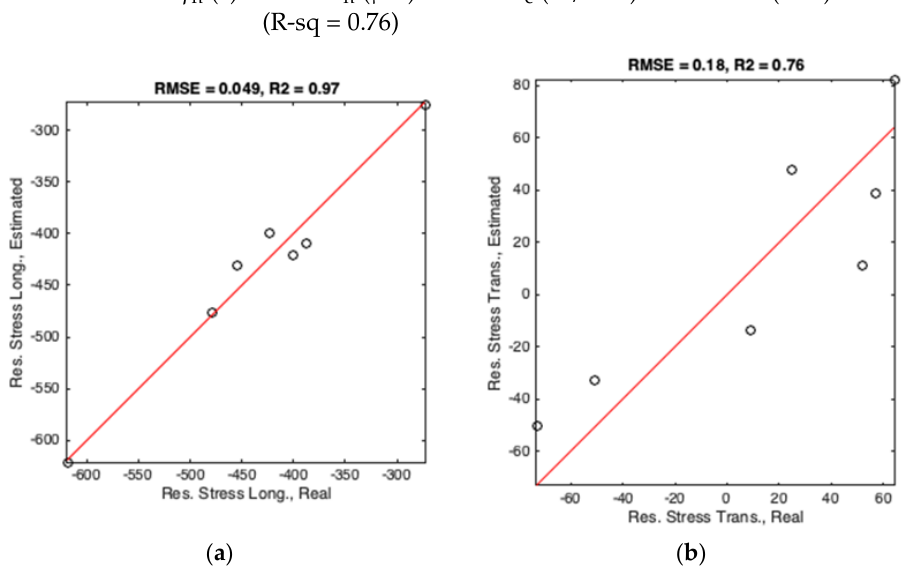
Figure 11. Accuracy indicators for the ( a ) longitudinal and ( b ) transversal residual stresses (cutting conditions 1, 3, 5, 6, 7, 13, and 14).